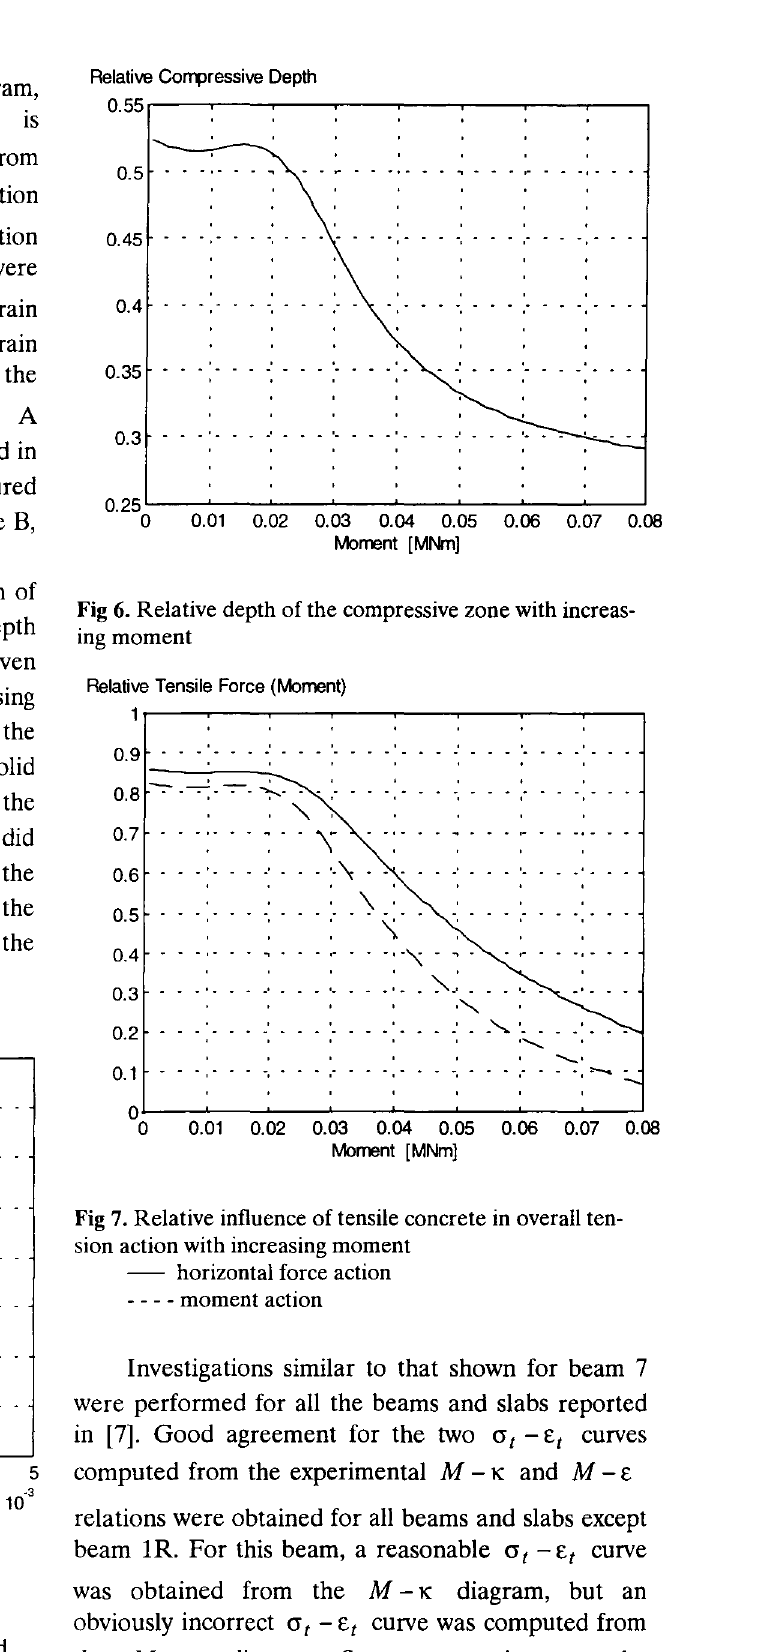
Fig 5. Moment-curvature relationships for beam 7: oooo - averaged and smoothed experimental - computed when cr curve was obtained 1 - E 1 from M- Es relationship (case A) the same (case